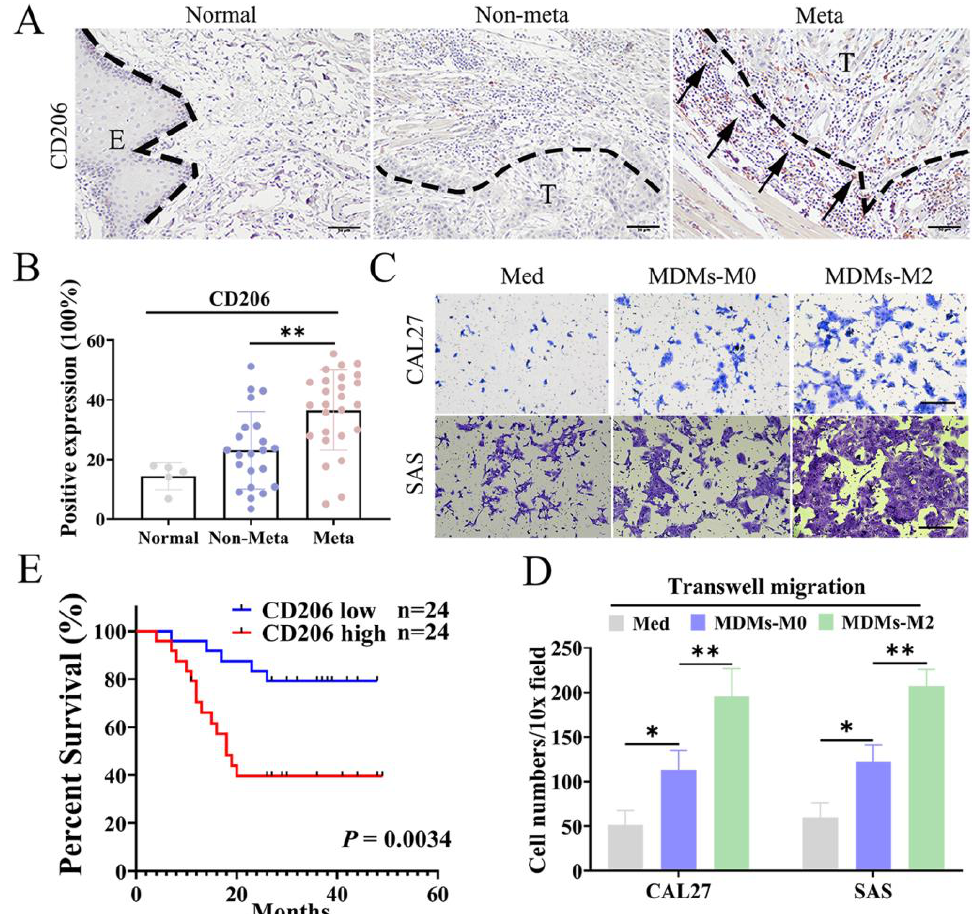
Figure 1. M2 TAMs enhanced OSCC metastasis and were correlated with poor prognosis of OSCC patients. ( A ) Representative images of CD206 staining in non-metastasis, metastasis, and paired para-tumor tissues from same patients. The positive staining has been highlighted by black arrows. E: Epithelium um, T: Tumor nest. Scale bar: 50 um. ( B ) Statistical results of CD206 positive expression in 26 OSCC specimens with neck lymph node metastasis and 22 without metastasis. ( C , D ) Transwell migration assays of CAL27 and SAS cells co-culturing with indicated macrophages were performed and statistical results were shown by the bar graph. Scale bar: 50 um. ( E ) Survival curves of 48 OSCC patients with low or high CD206 expression. The p value was determined by log-rank test. All experiments were performed in triple times, and the data were presented as the means ±